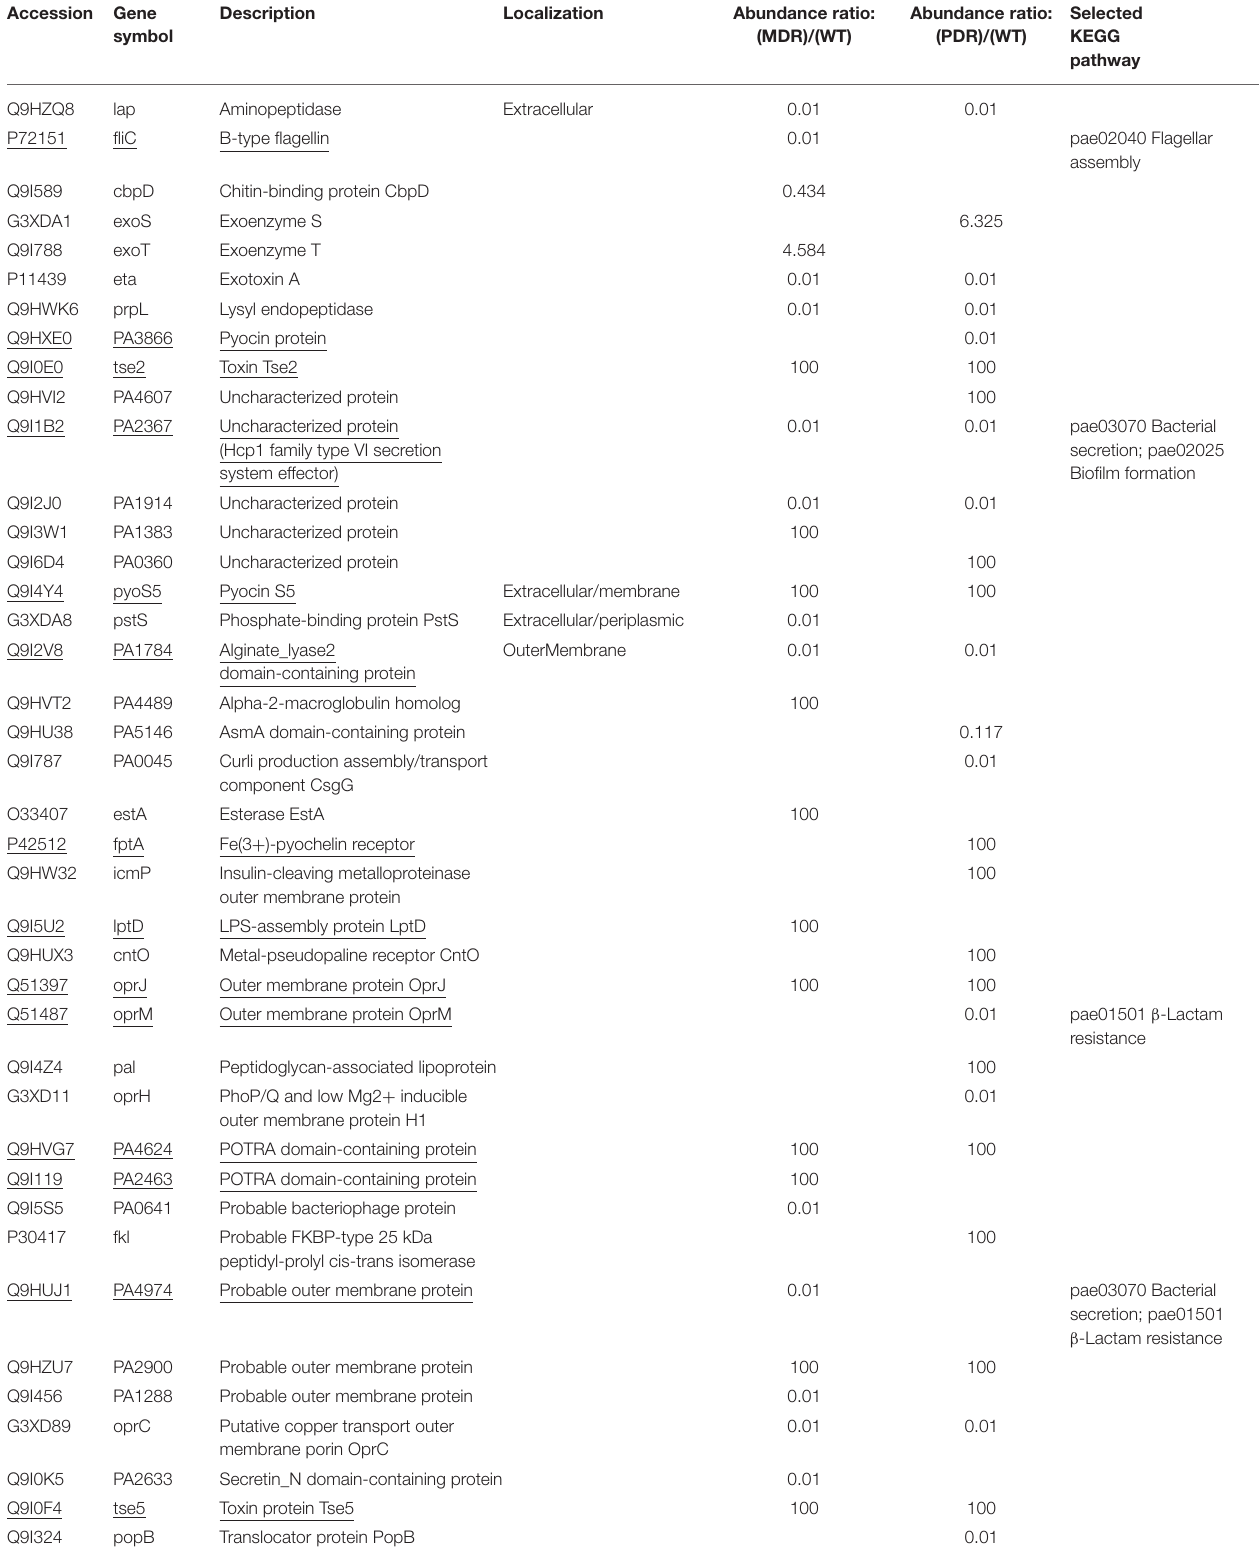
TABLE 2 | List of differential P. aeruginosa identified MDR and PDR proteins vs. WT mapped in the region between the extracellular space and the cytoplasmic membrane. Accession Gene